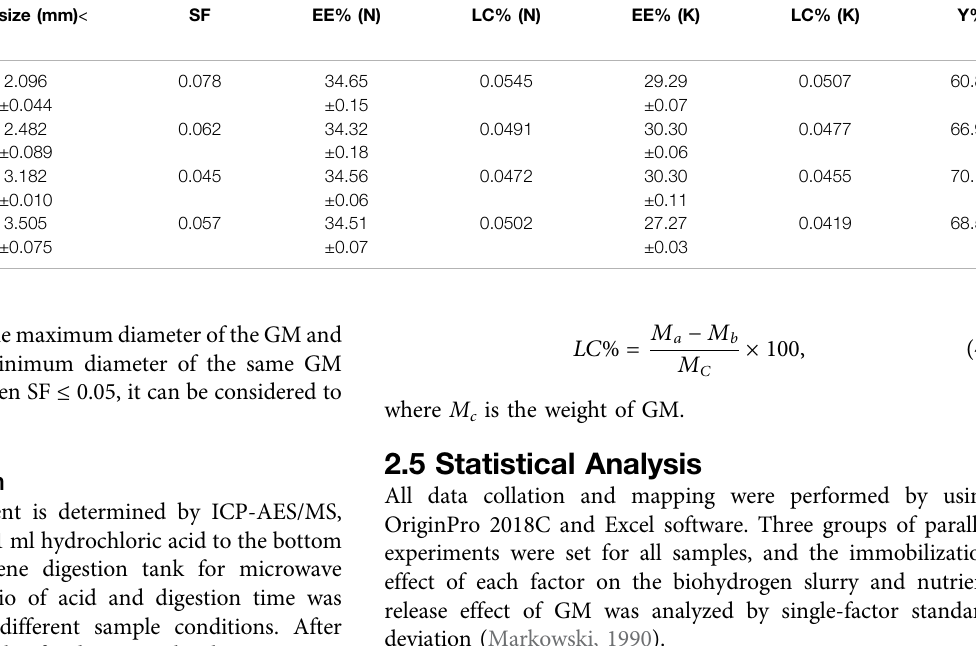
TABLE 2 | Effects of GM with different sizes on the immobilization of nutrients. Syringe needle size